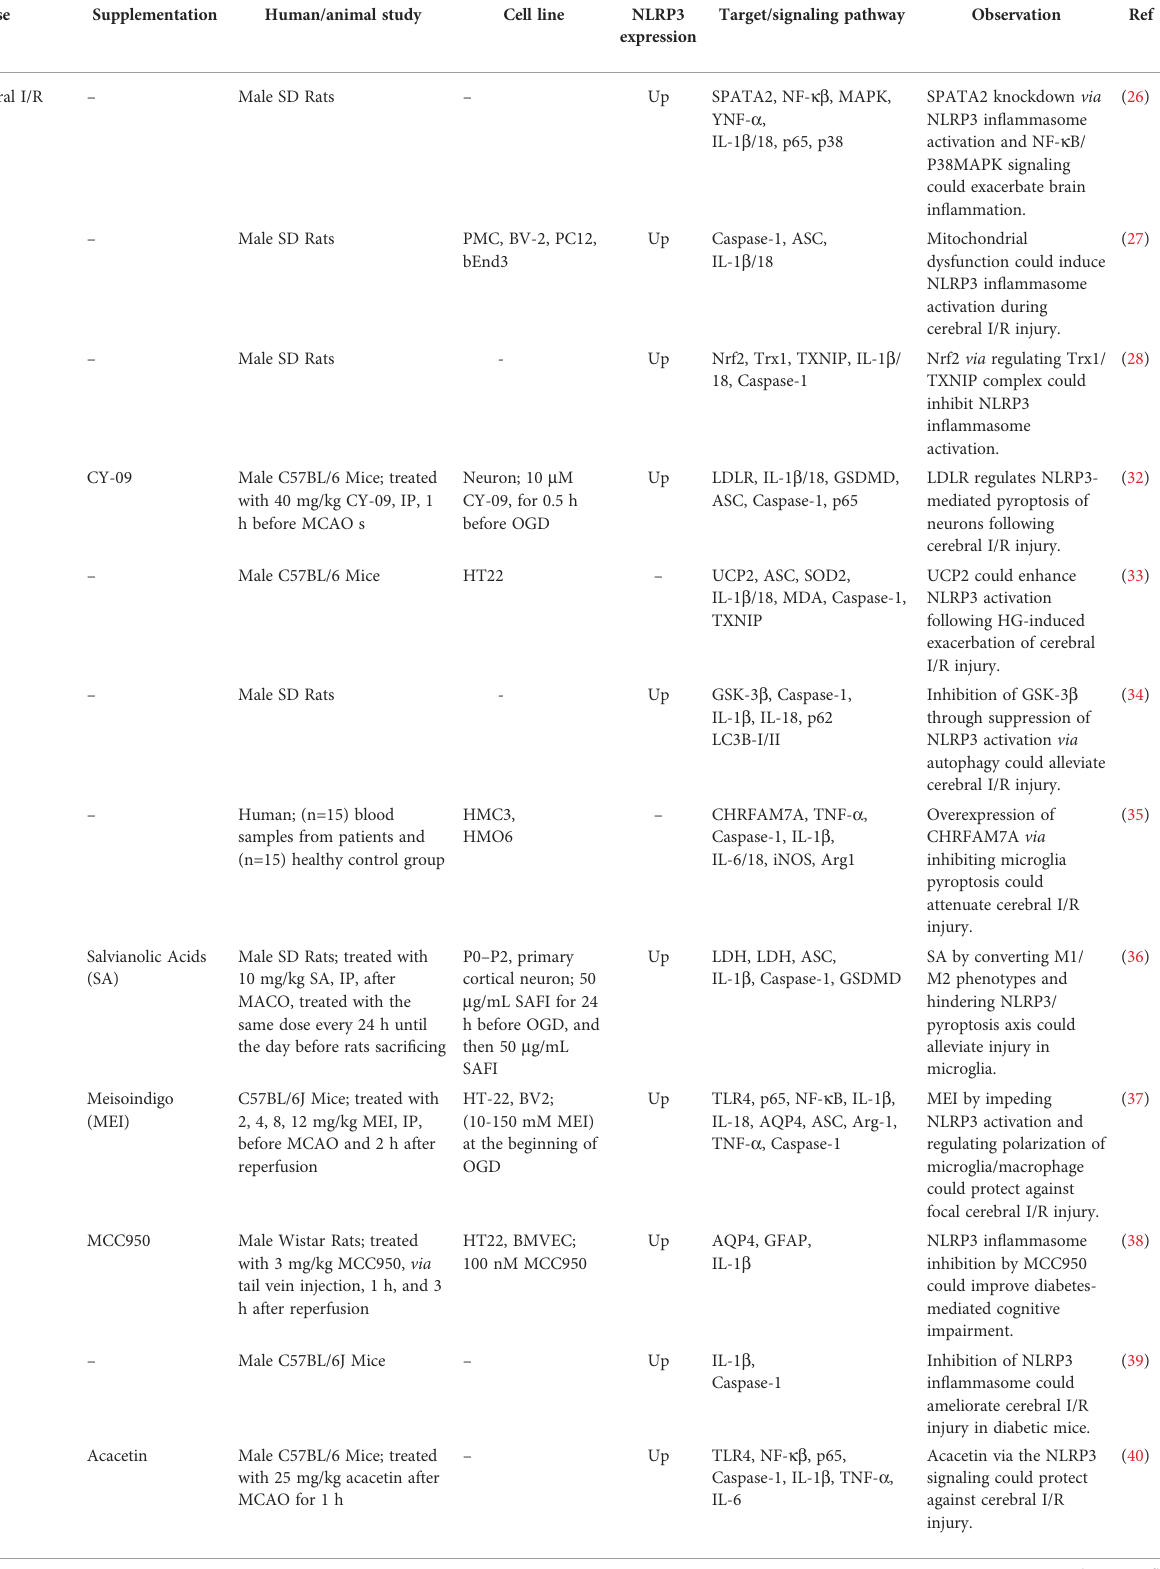
TABLE 2 Role of NLRP3 in Neurovascular I/R